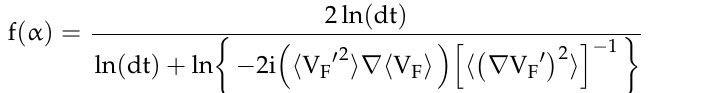
Figure 6. Bifurcation map of singularity spectrum f(α)(x) ; control parameter: Ω . In order to draw parallels between the theory and real data, it is required to introduce experimental ceilometer data. These data shall be used to calculate the initial and final turbulent scales in order for the Reynolds number profile and the atmospheric fractal di- mension profile to be obtained, and for this, the structure coefficient of the refraction index profile C (cid:2898)(cid:2870) (L) must be calculated through the following equation [18,26]: σ (cid:2893)(cid:2870) (L) = 1.23 C (cid:2898)(cid:2870) (L)k (cid:2875) (cid:2874) L (cid:2869)(cid:2869) (cid:2874) (51) where σ (cid:2893)(cid:2870) is the “scintillation,” the logarithm of the standard deviation of light intensity of a source of light observed from a distance represented by the optical path L . I refers to the intensity of the backscattered range-corrected lidar signal at the particular point in the optical path, i.e., the RCS (range corrected signal) intensity, and this can be used to calculate the scintillation [11,17,18,26]. In past studies it has been deemed and proved